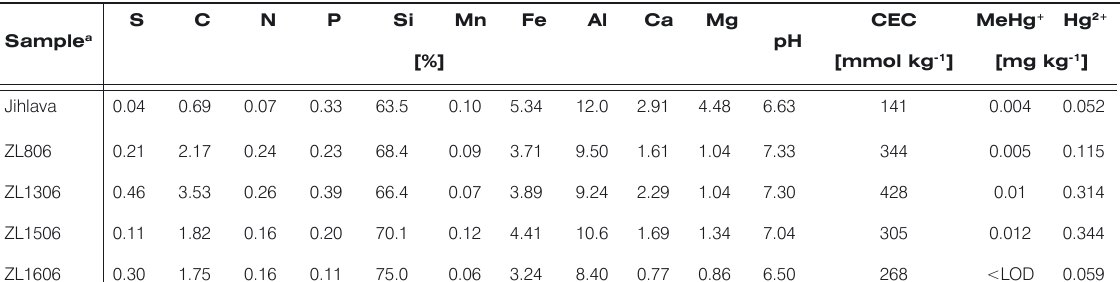
Table 1. Sediment chemical